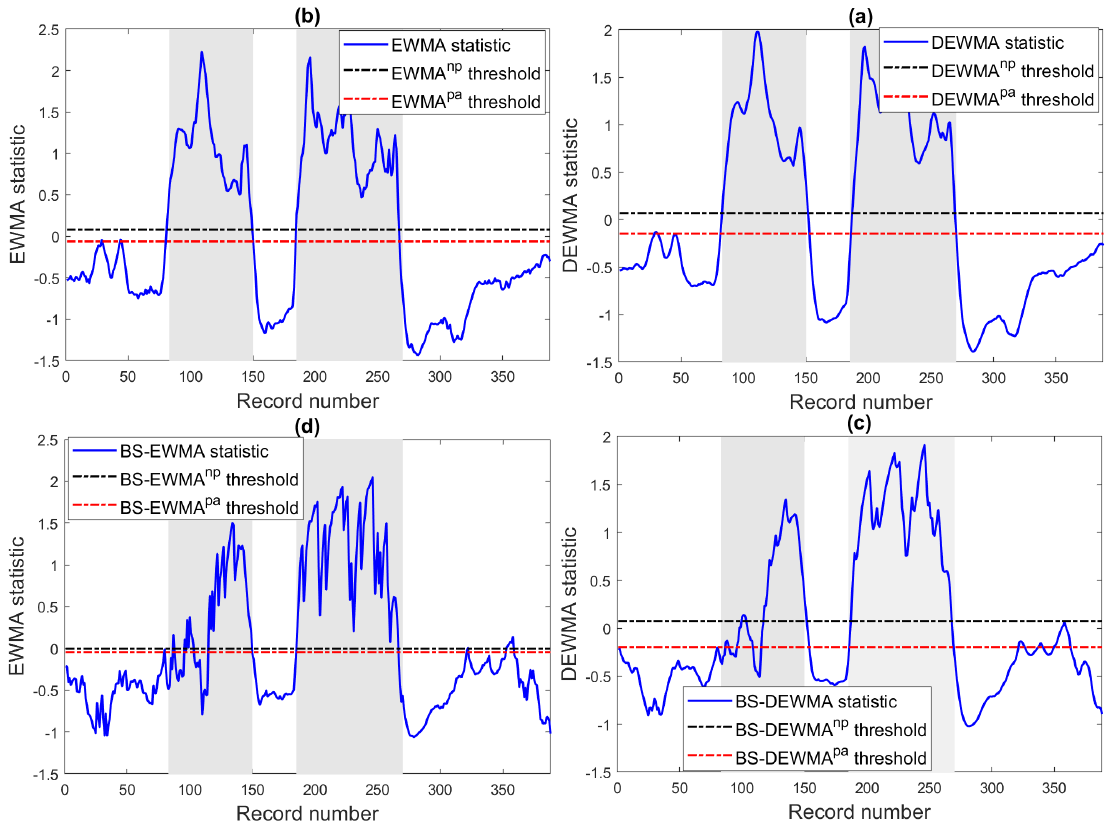
Figure 17. Results of the BG and BS-based schemes in monitoring partial shading: ( a ) BG-DEWMA, ( b ) BG-EWMA, ( c ) BS-DEWMA, and ( d ) BS-EWMA